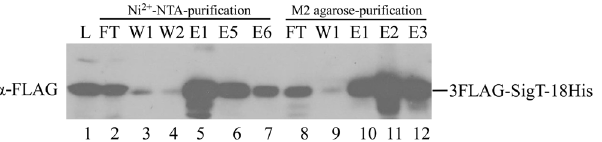
Figure 3. Immuno-blot assays of samples during tandem affinity purification (TAP) with anti-FLAG antibody. Total protein from S. coelicolor Δ prcB/A expressing 3FLAG-SigT-18His was subject to sequential nickel-based and anti-FLAG antibody-based affinity purification. Samples were taken during TAP as described in Materials and Methods. L: total lysate. FT: flow through. W: wash. E: